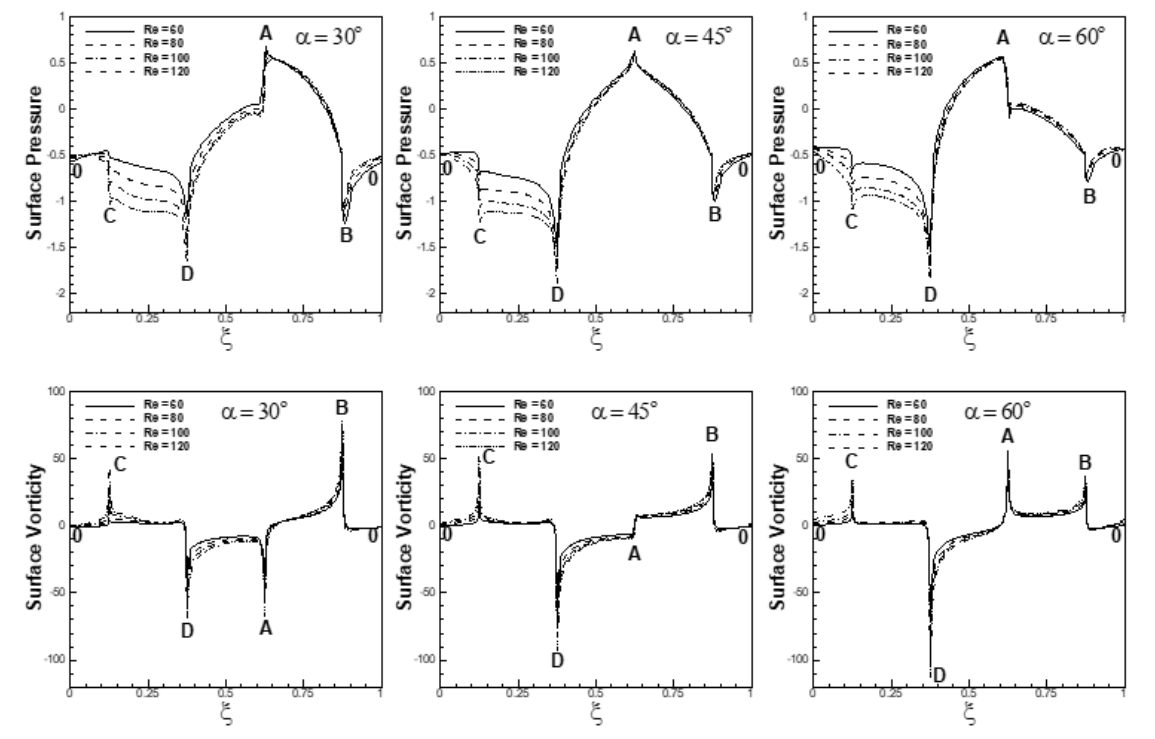
Figure 19. Mean pressure and mean vorticity along the surface of the cylinder for 60 ≤ Re ≤ 120 and 30° ≤ α ≤ 60° at Ri = 0.2.